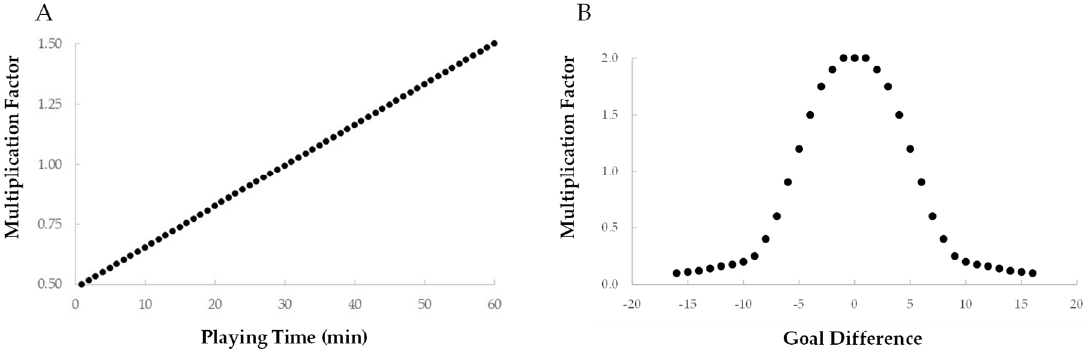
Figure 1. Linear function ( A ) for the playing time factor and Gaussian bell function ( B ) for the goal difference factor in the PlayerScore.